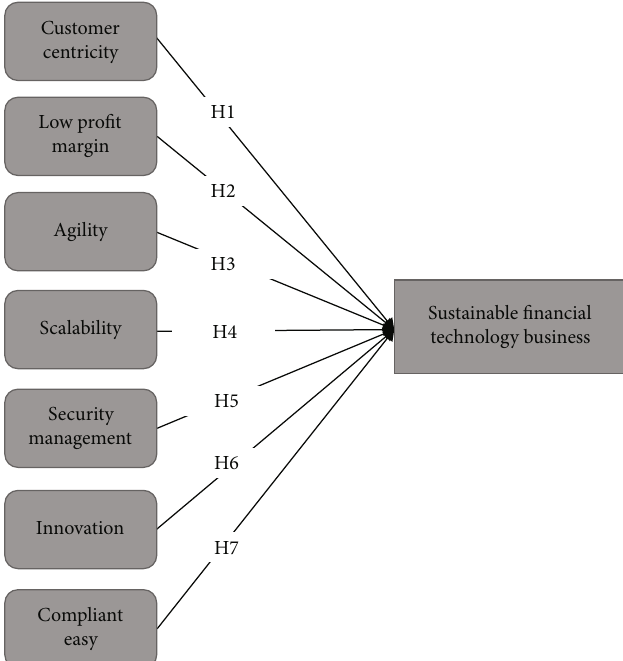
Figure 2: Sustainable fi ntech business structure model